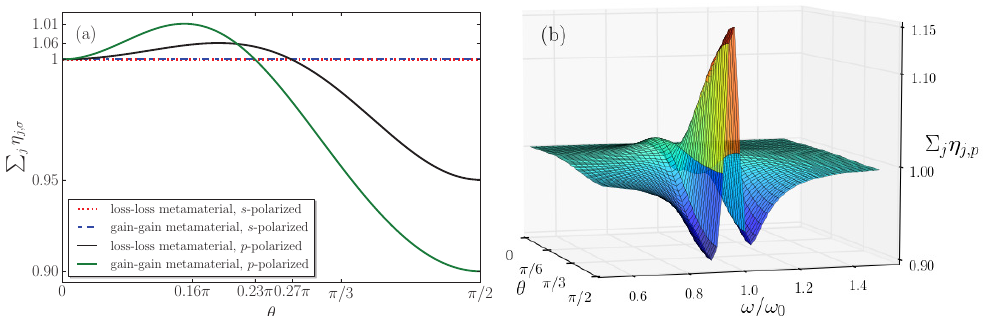
Figure 2. (Color online) ( a ) The sum Σ j = a , b η j , σ is shown as a function of the angle of incidence θ for s -polarized component of input light impinging on the loss-loss (dotted red line) and the gain-gain (dash-dotted blue line) multilayers, and p -polarized component of input light incident on the loss-loss (solid black line) and the gain-gain (solid green line) multilayers. ( b ) The sum Σ j = a , b η j , p is shown as a function of the angle of incidence θ and of the dimensionless frequency ω / ω 0 for p -polarized component of input light impinging on a gain-gain multilayer. The multilayer metamaterial with geometry of Figure 6 has alternating layers with equal thickness d a,b ω 0 / c = 0.1, with dielectric parameters in Equation (40): ω p / ω 0 = 0.3, ω p / ω 0 = 0.1 and γ a,b / ω 0 = 0.1. In panel ( a ), we choose a b ω / ω 0 =